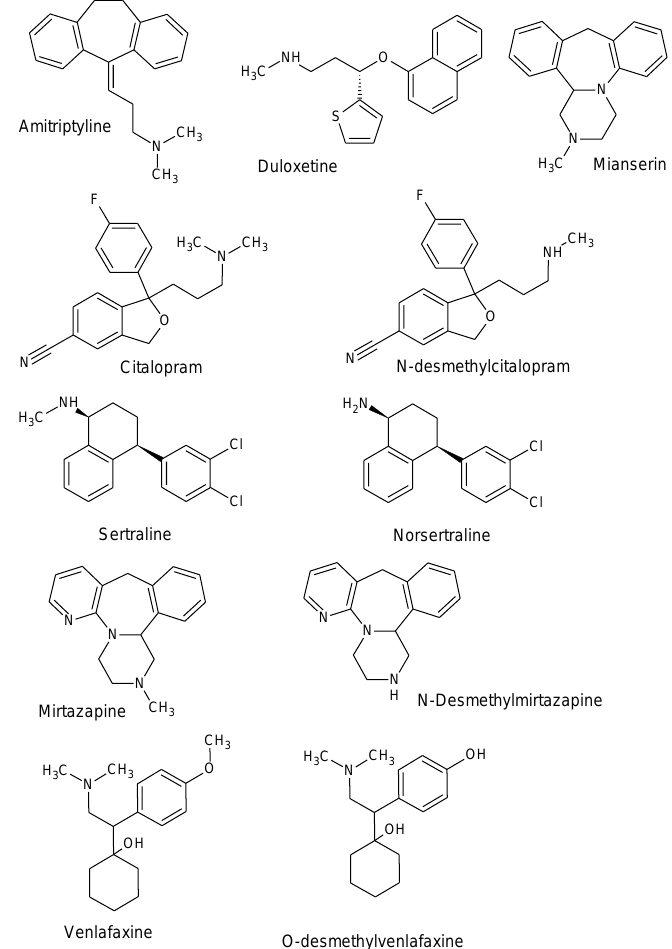
Figure 1. Chemical formulas of the analyzed substances and their metabolites.